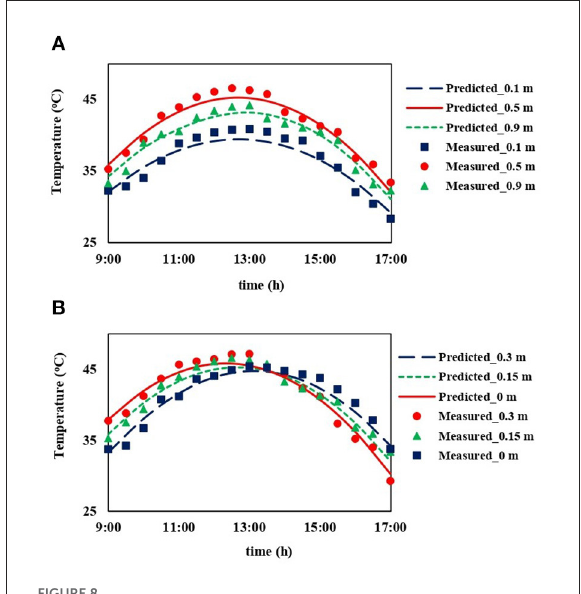
FIGURE8 Validation of the predicted temperature profiles at different positions inside the onion bulk of the solar dryer during an 8-h day of curing: (A) at 3 positions along the length in the symmetry plane at mid-height of bulk, (B) at 3 positions along the height in the center of the bulk layer.